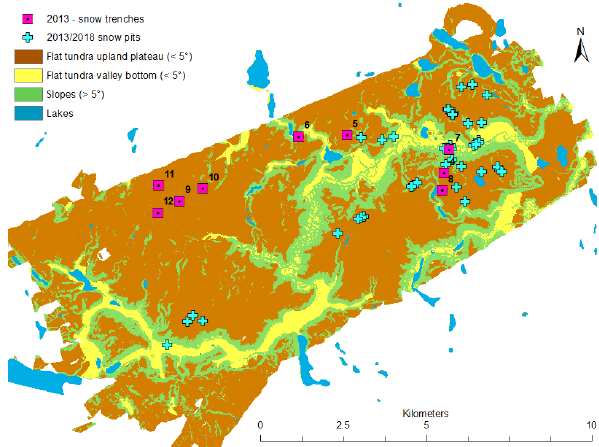
Figure 1. Locations of snow trenches excavated in April 2013 are indicated by the pink squares. Locations of snow pits excavated in April 2013 and March 2018 are indicated by the blue crosses. Brown, yellow, green, and blue colours on the map denote the dif- ferent terrain types identified by the topographic position index. In 2018, five additional pits were located on Husky Lakes (not on map), approximately 5km to the east of the presented